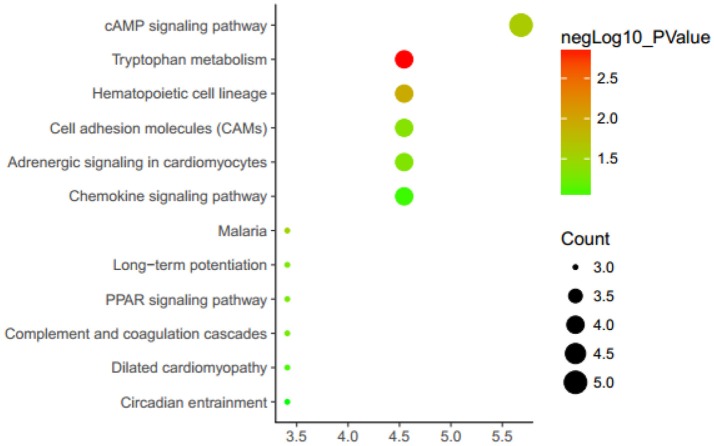
Enrichment analysis KEGG metabolic pathways. KEGG, Kyoto Encyclopedia of Genes and Genomes. Genes are associated with up/down expression levels (green/yellow/red coloring).